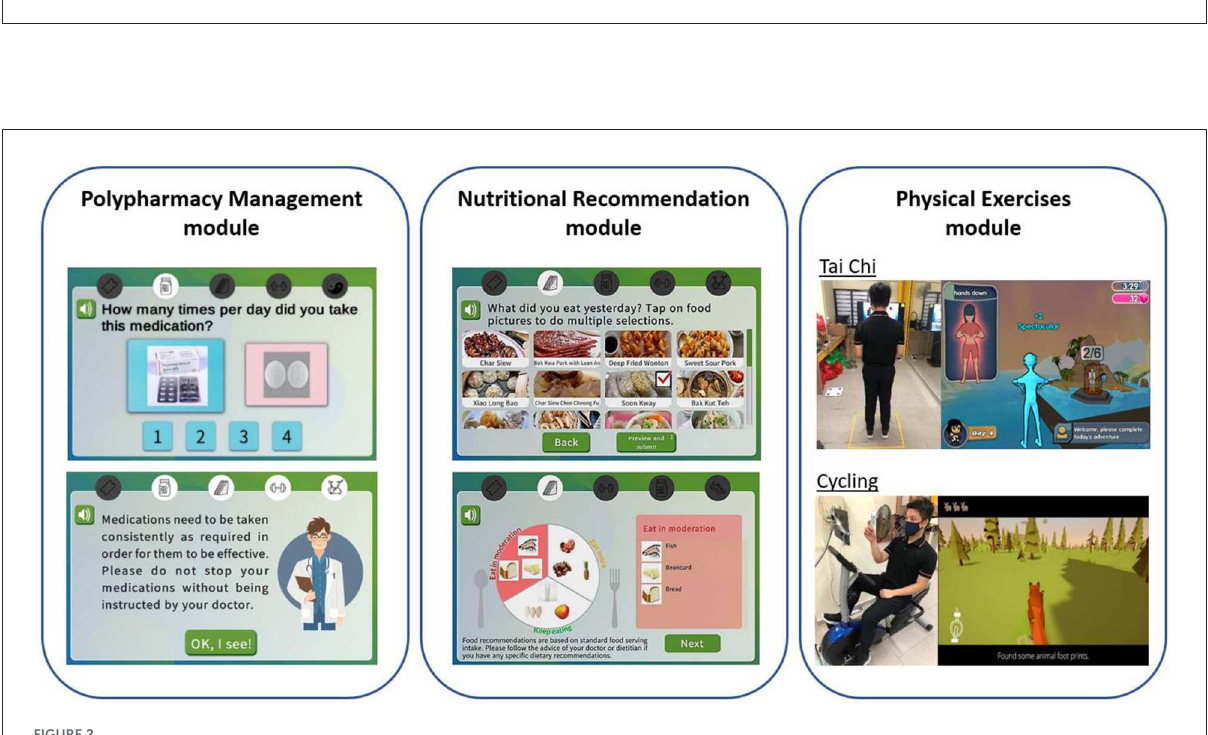
FIGURE2 Illustration of system for assessment and intervention of frailty (SAIF) intervention modules which consist of polypharmacy management, nutritional recommendation, and physical exercises